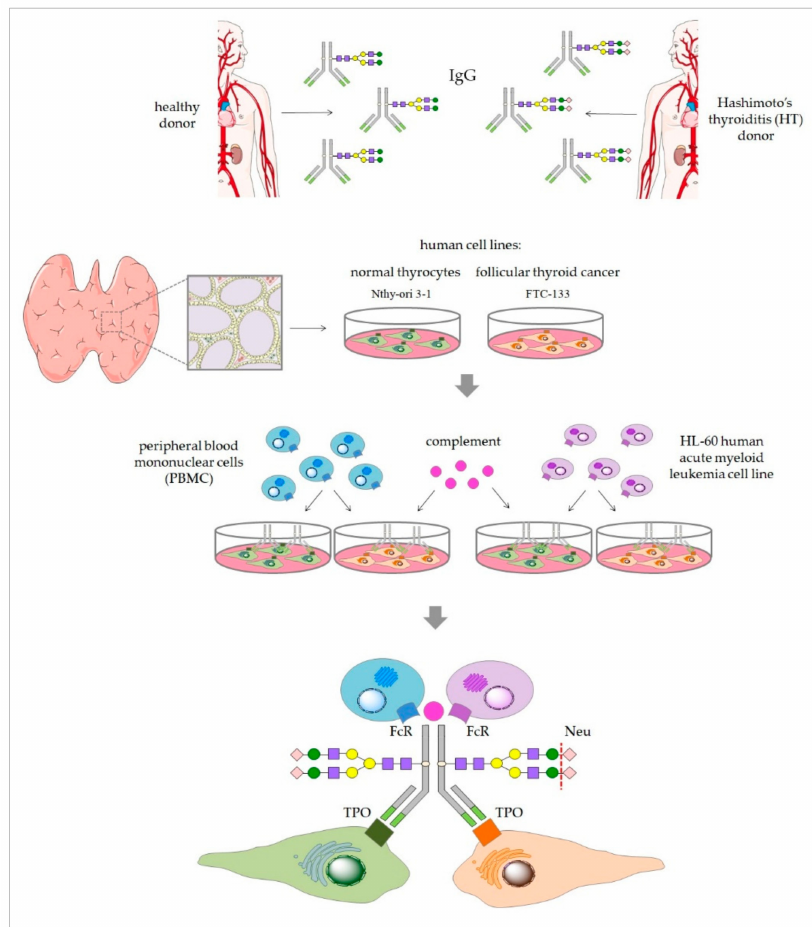
Figure 1. Scheme of antibody-dependent cell-mediated cytotoxicity (ADCC) and complement- dependent cytotoxicity (CDC) models and experiment stages. IgGs were isolated from Hashimoto’s thyroiditis (HT) and healthy donor (C, control) sera and treated with neuraminidase (Neu) to remove sialic acid from N -glycans. The key components involved in ADCC and CDC are the target cells expressing an autoantigen (thyroperoxidase, TPO), IgGs (isolated from HT and C donors) containing thyrocyte-antigen-specific anti-TPO, and e ff ector cells with a surface receptor for IgG crystallizable fragment Fc (FcR) in the ADCC model and the complement in the CDC model. Nthy-ori 3-1 and FTC-133 cell lines were used as the target cells; PBMC isolated from healthy donors and the HL-60 cell line were used as the e ff ector cells. Intact and Neu-treated IgGs from HT and the control were used as a variable element triggering ADCC and